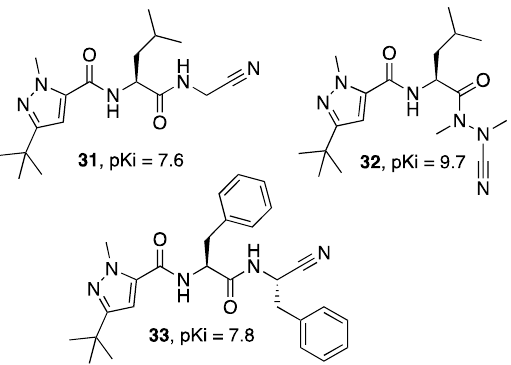
Figure 8. Structures of cysteine protease B inhibitors ( 31 – 33 ).